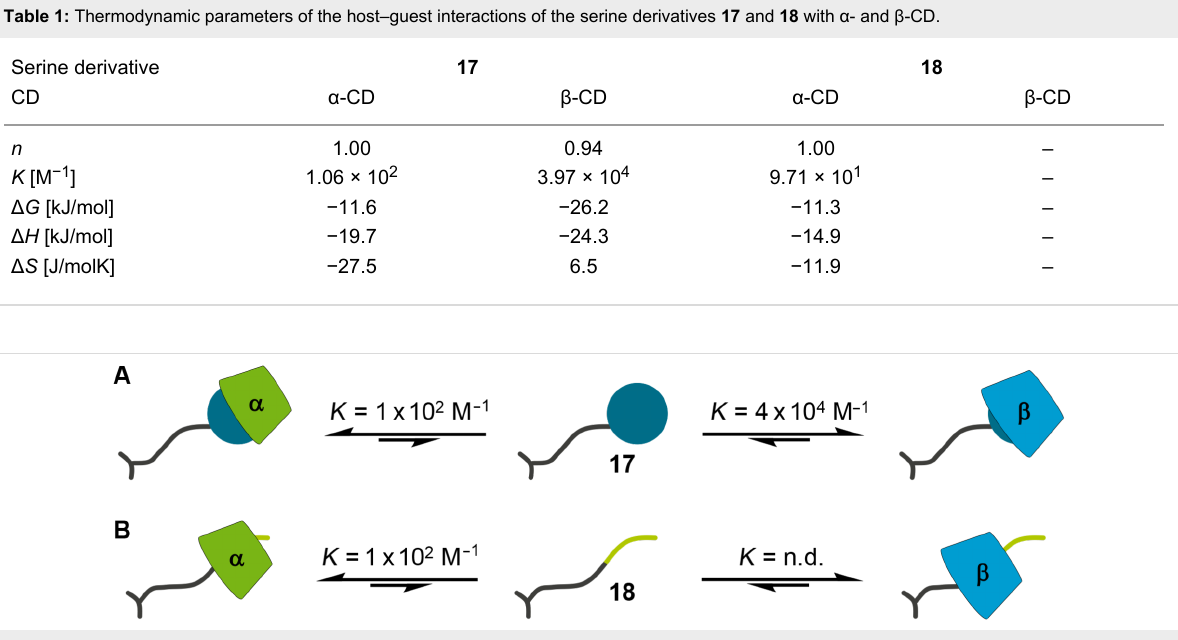
Figure 5: Schematic drawing of the complexation of the serine derivatives 17 (A) and 18 (B) with α - and β -CD. The shown binding constants were determined by ITC, the structures by NMR. n.d. = not detectable by